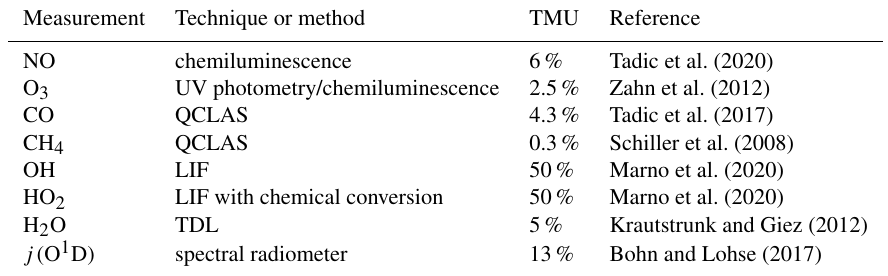
Table 1. List of performed observations with the corresponding total measurement uncertainty (given as a percentage) during CAFE-Africa. The last column provides a reference regarding the practical use of the used measurement or